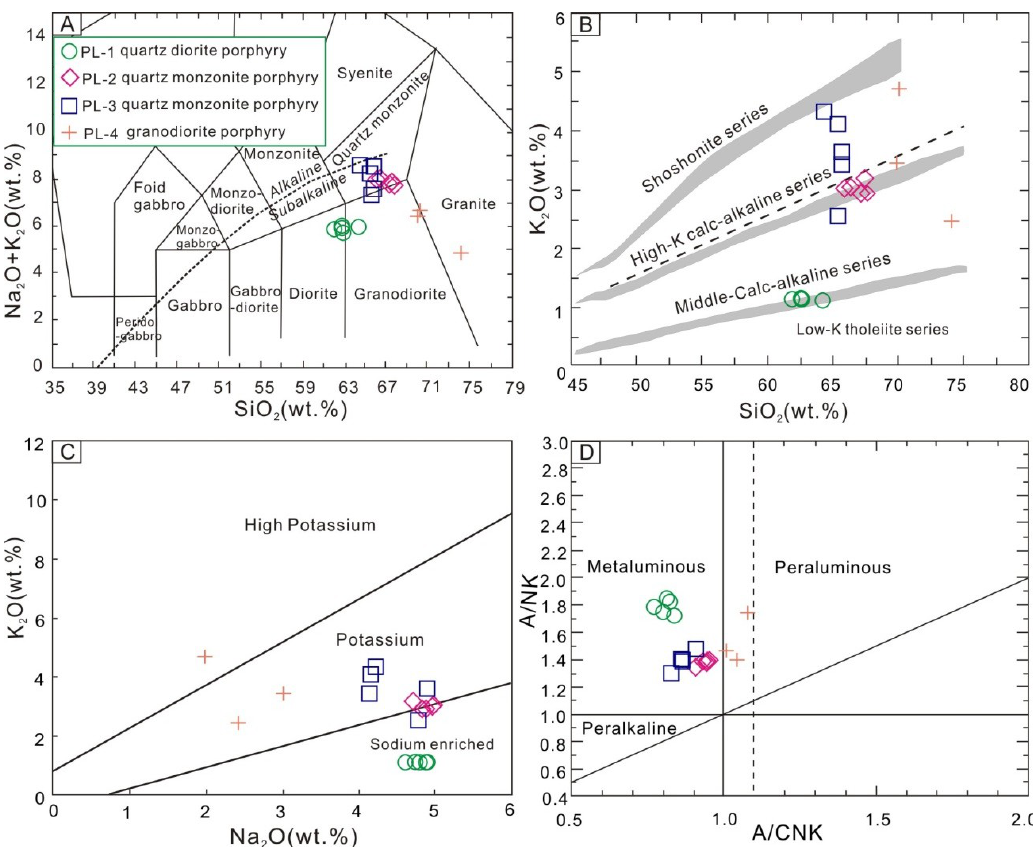
Figure 8. ( A ) Diagrams of SiO 2 vs. Na 2 O + K 2 O (based on Irvine and Baragar [51]); ( B ) SiO 2 vs. K 2 O (based on Peccerillo and Taylor [52]); ( C ) Na 2 O vs. K 2 O (based on Middlemost [53]); ( D ) A/CNK vs. A/NK for the Pulang porphyry intrusions (based on Maniar and Piccoli [54]).